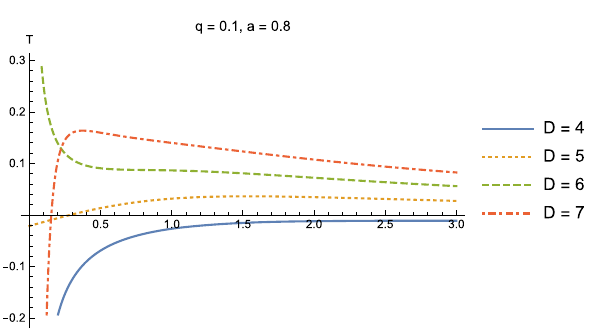
Fig. 12 Hawking temperature in Gauss–Bonnet gravity as function of r h , for a = 0 . 8 and q = 0 .